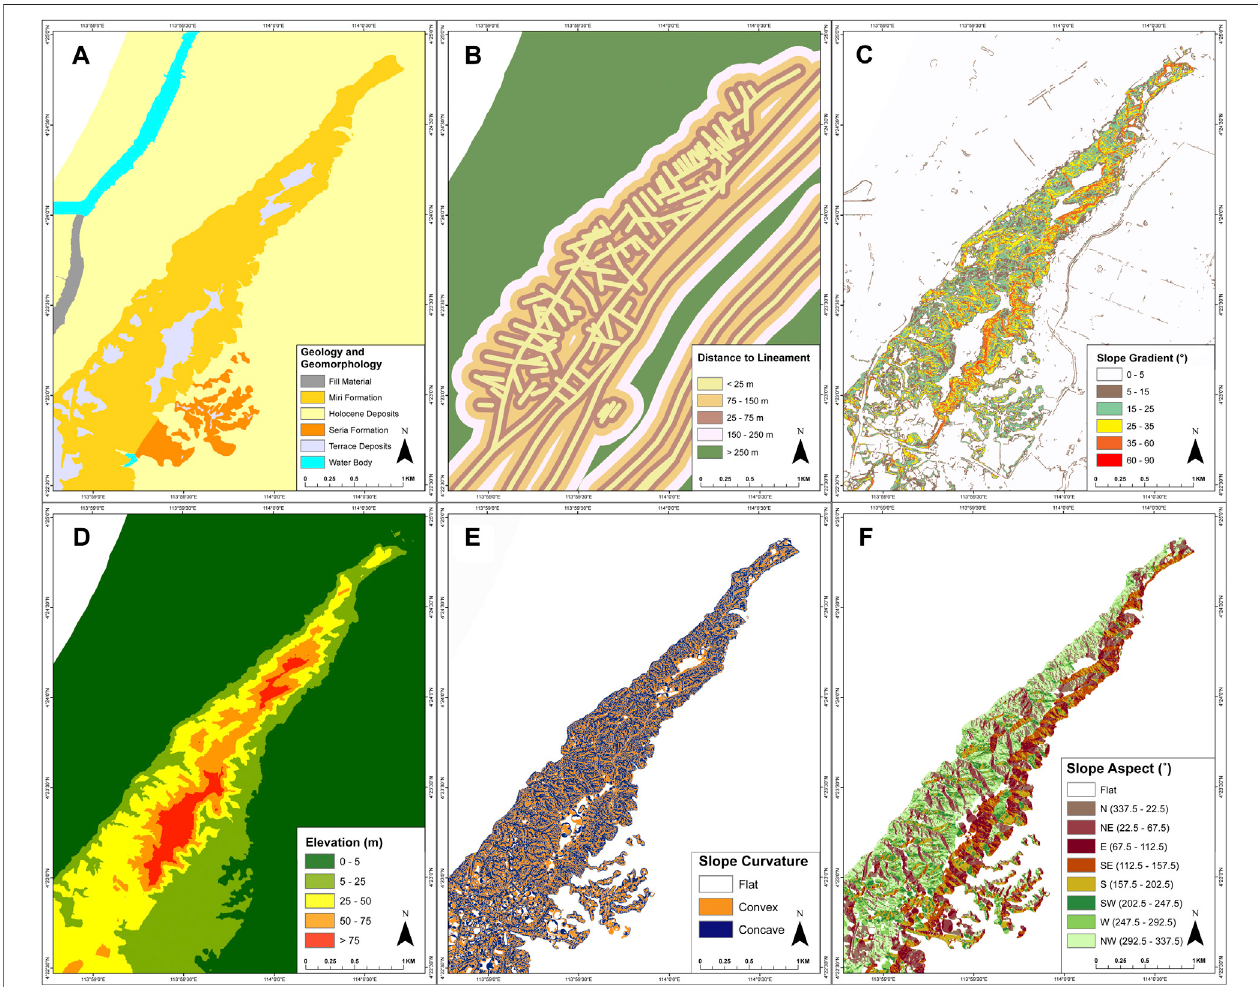
FIGURE 3 | Landslide-conditioning parameter maps. (A) Geology and geomorphology (B) distance to lineament (C) slope gradient (D) elevation (E) slope curvature, and (F) slope aspect.